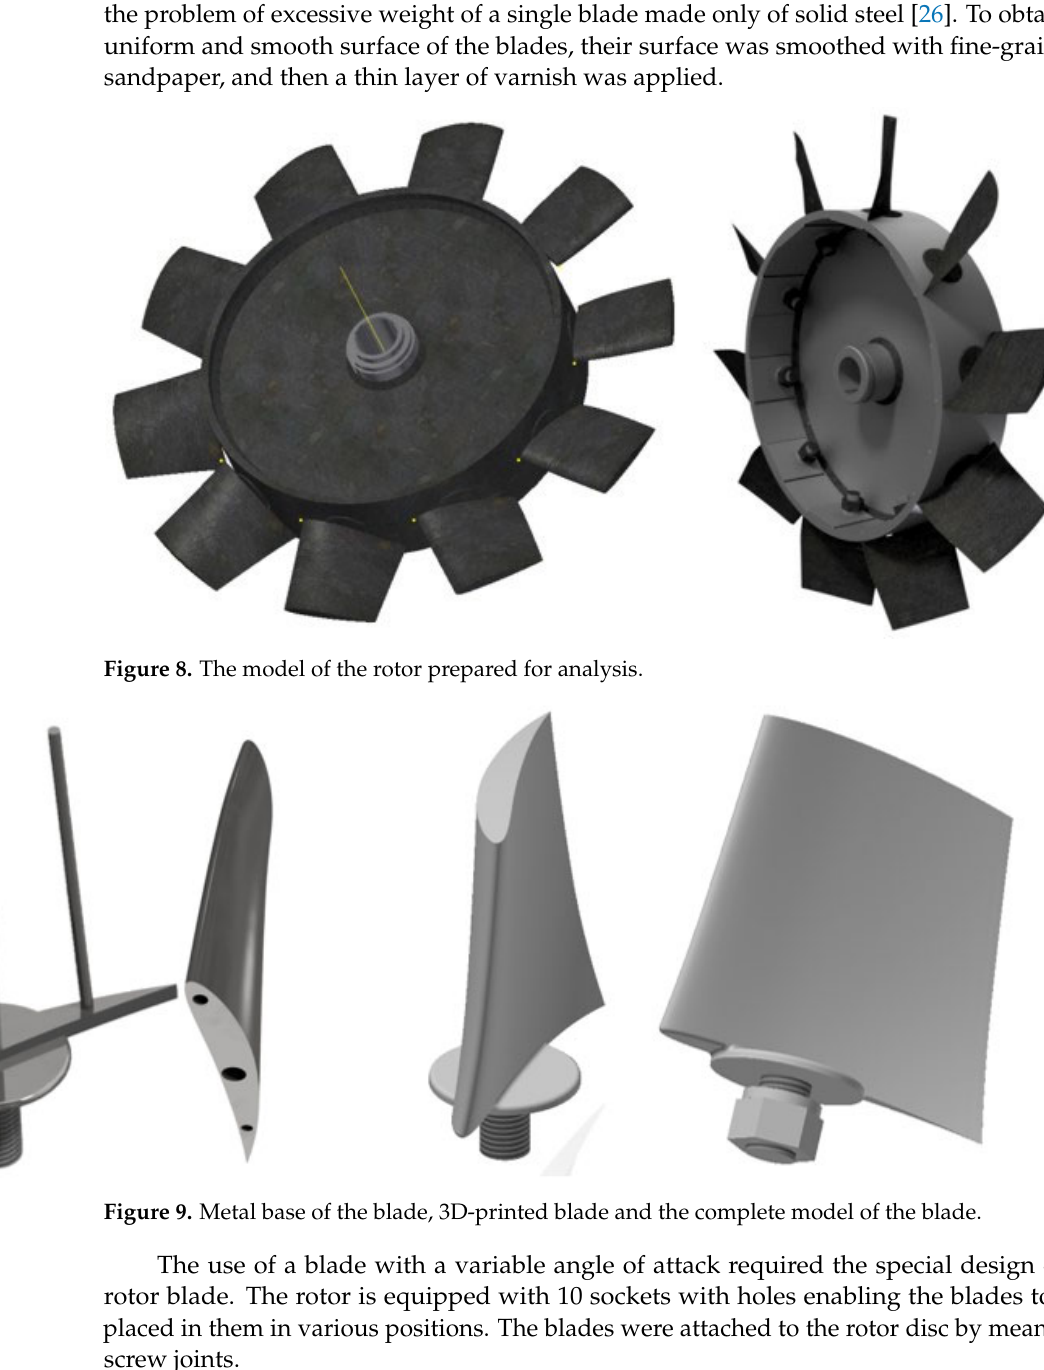
Figure 10. Boundary conditions of the computational model: front view ( a ), side view ( b ). As a result of the high rotational speed of the rotor at 3450 rpm, stresses arise in the blade and in the place where it is fixed in the hub. The results of the FEM analysis re- garding the blade are presented in Figure 11, and the analysis regarding the place of its mounting on the hub is shown in Figure 12. The results indicate in red the maximum stress of 400 MPa, and therefore the steel sheet for the rotor structure should have a yield